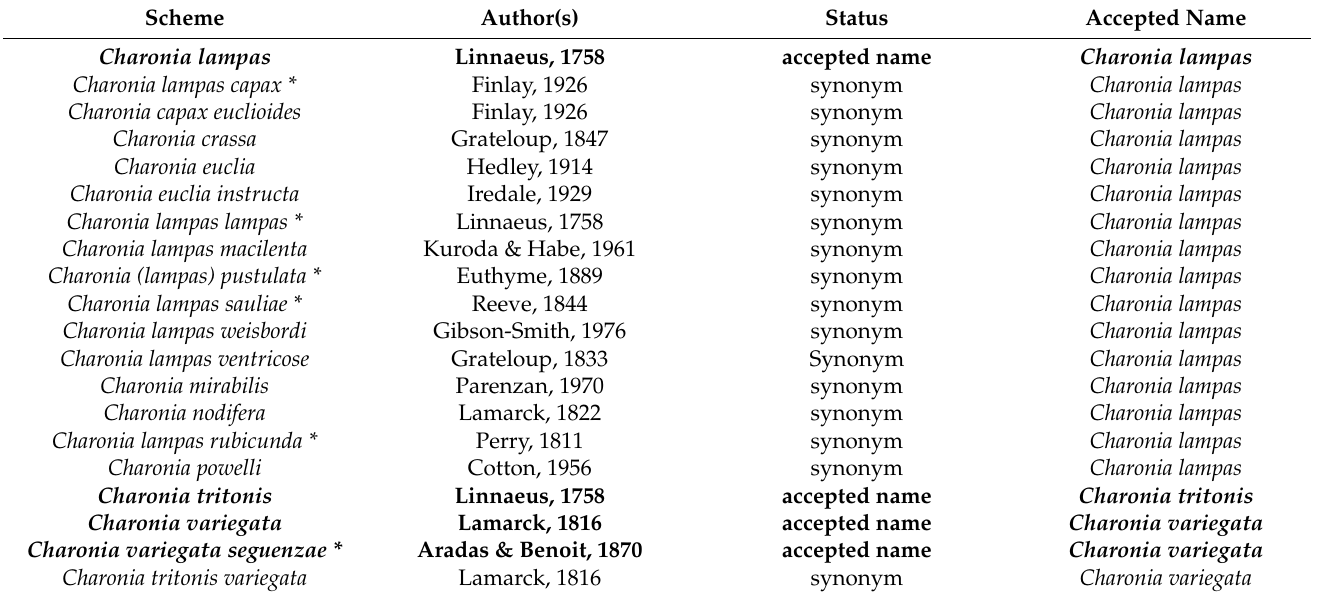
Table 1. Taxonomic status of the genus Charonia . Key taxonomic groups in bold, * denotes initial subspecies. Adapted from